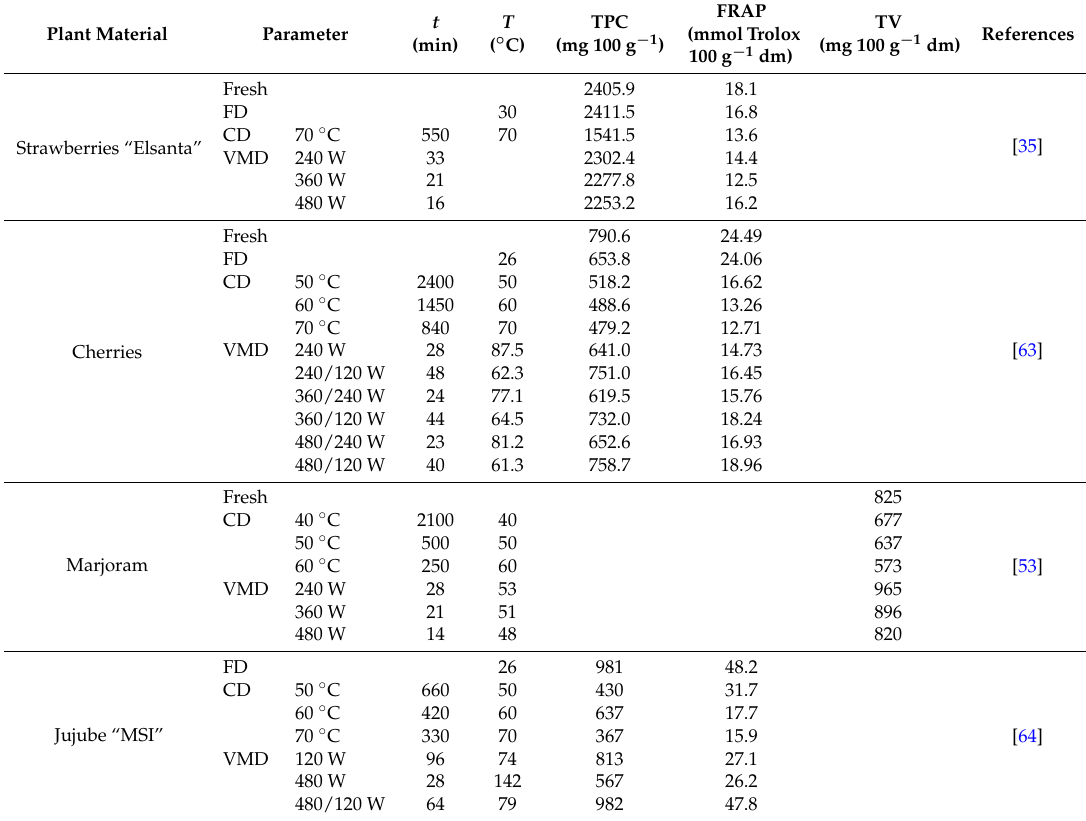
Table 1. Processing parameters (drying time ( t ) and maximum temperature ( T )), total polyphenols content (TPC), antioxidant capacity (FRAP) and total volatiles content (TV) in different plant materials dehydrated by freeze drying (FD), convective drying (CD) and vacuum-microwave drying (VMD) at different processing